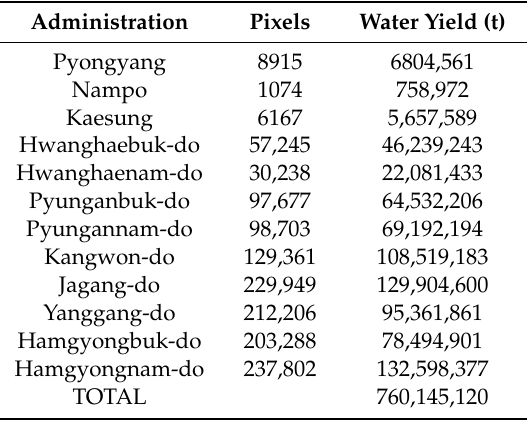
Table 3. Water yield of North Korean forests by administrative